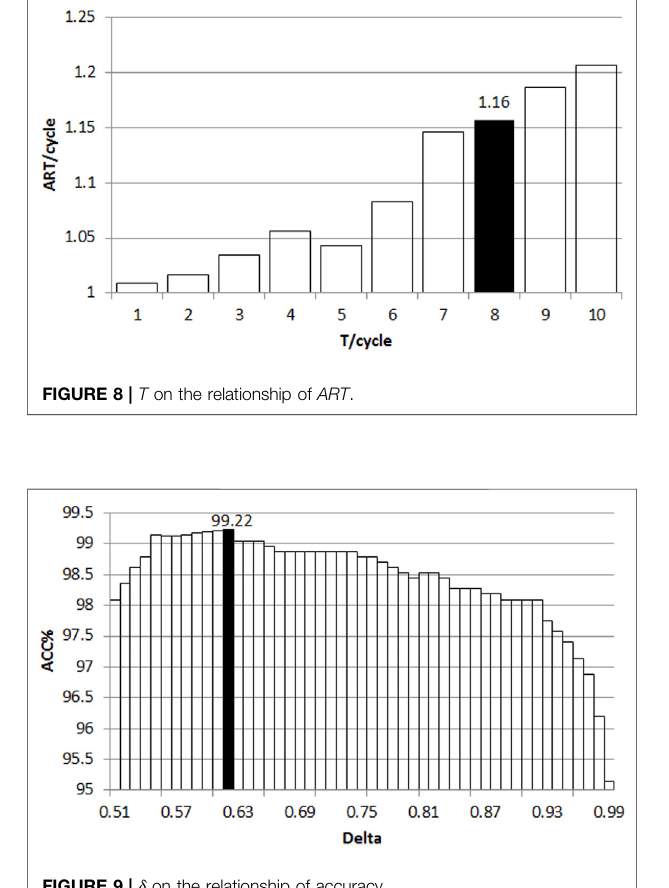
FIGURE 9 | δ on the relationship of accuracy.